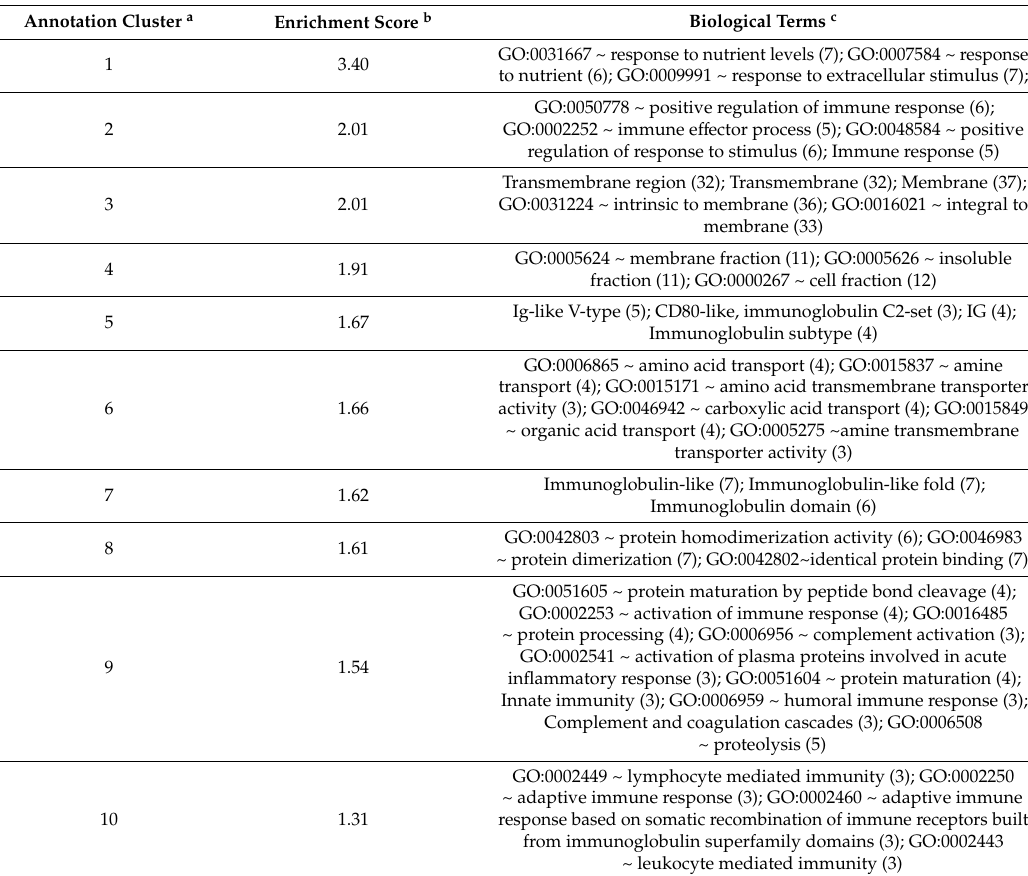
Table 4. Functional annotation clusters of biological terms representing downregulated genes in NR non-IUGR compared to NR IUGR